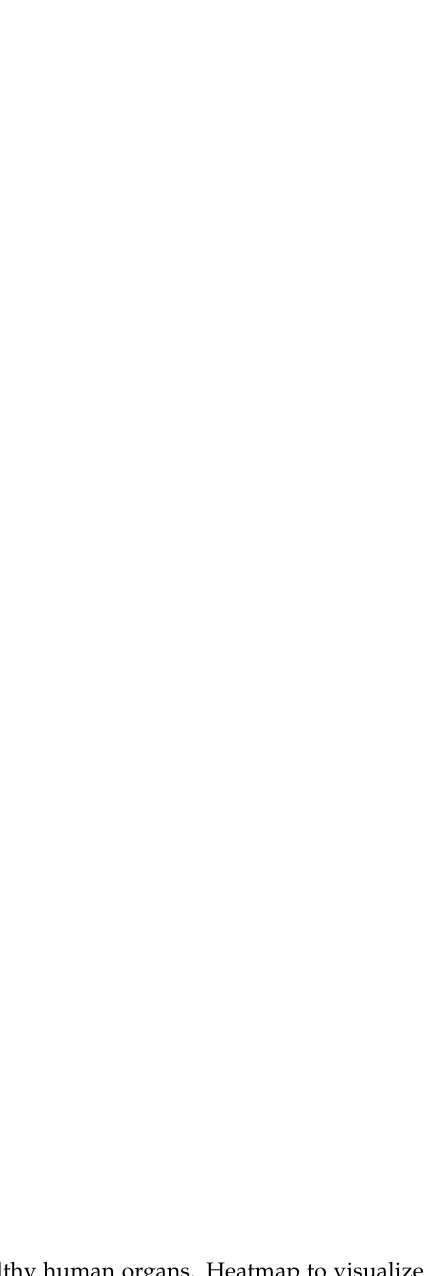
Figure 1. The distribution of PD-L1 in various healthy human organs. Heatmap to visualize the expression of PD-L1 by an RNA-seq data set analysis.